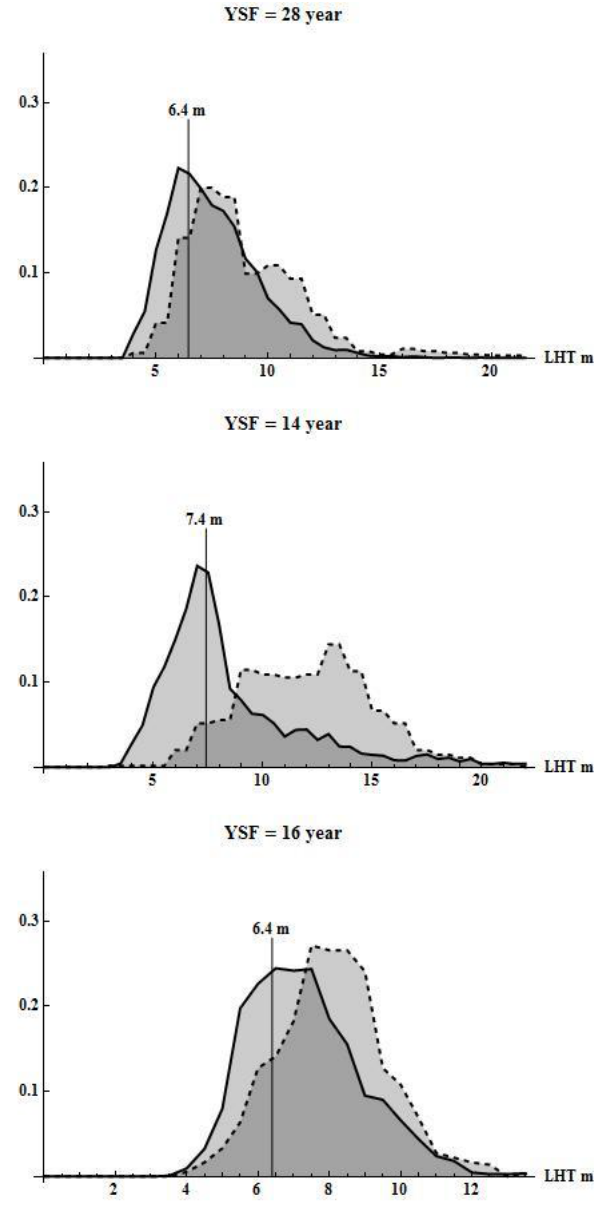
(full outline) in is indicated (dashed out